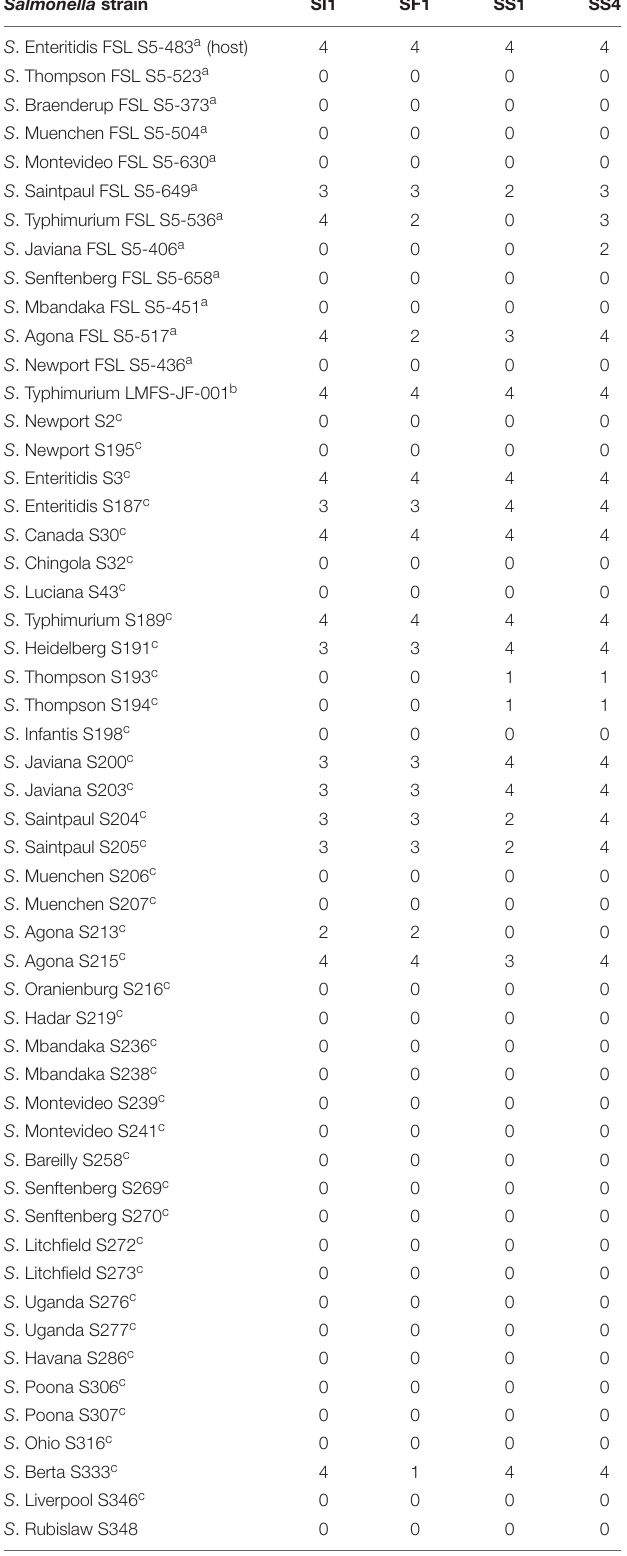
TABLE 1 | Host ranges of SI1, SS1, SS4 and